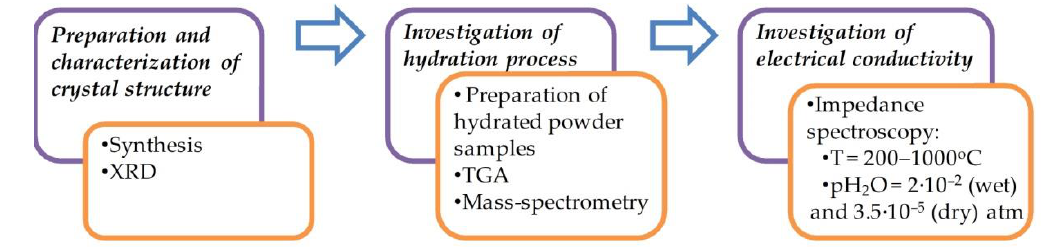
Figure 2. The scheme of investigations of perovskite La 2 ScZnO 5.5 and doped samples.